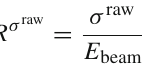
determinations of R (cid:6) E raw (cid:7) and R σ raw was estimated